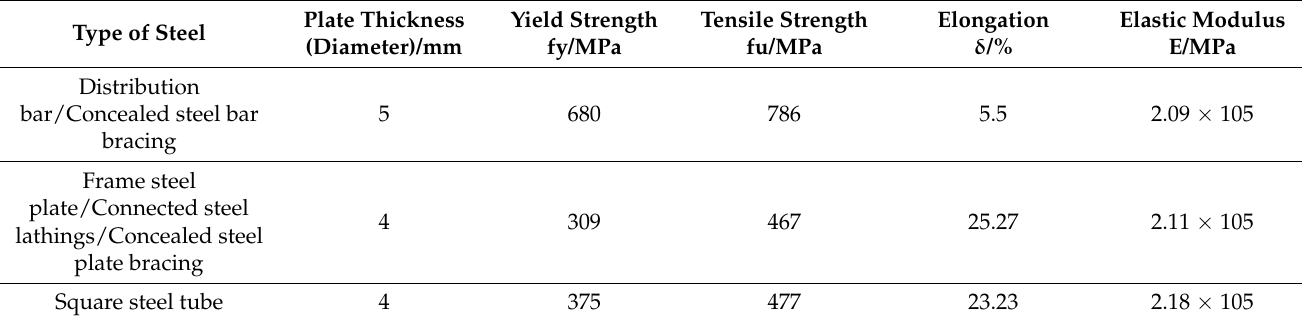
Table 3. Mechanical properties of steel.